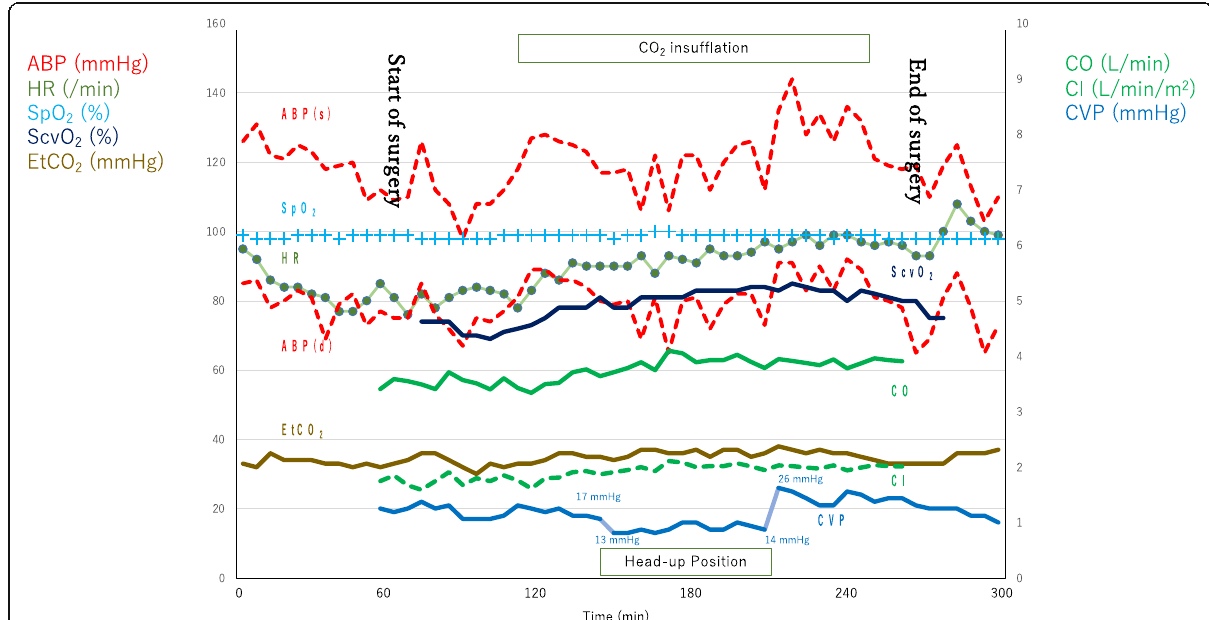
Fig. 1 Trends of hemodynamic parameters during anesthesia. ABP, arterial blood pressure; HR, heart rate; SpO 2 , saturation of peripheral oxygen; ScvO 2 , central venous saturation; EtCO 2 , end-tidal CO 2 ; CO, cardiac output; CI, cardiac index; CVP, central venous